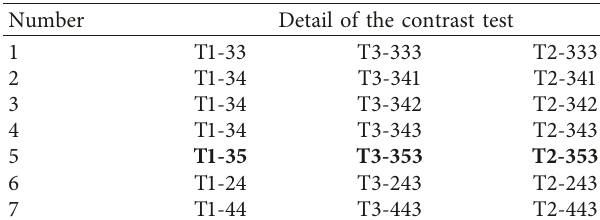
Table 4: The group of contrast